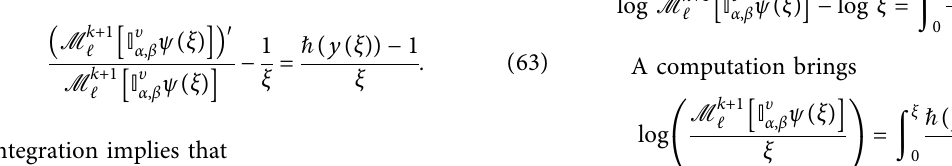
Figure 1: Plots of GKS of equation (45). (a) ψ ( ξ ) � ξ / ( 1 − ξ ) . (b) ( 1 + ξ ) / ( 1 − ξ ) . (c) [ I υ ψ ( ξ )] , when λ � 0 . 5 ,c � 1. (f) [ I υ λ � 0 . 25 ,c � 0. (e) [ I υ α , β